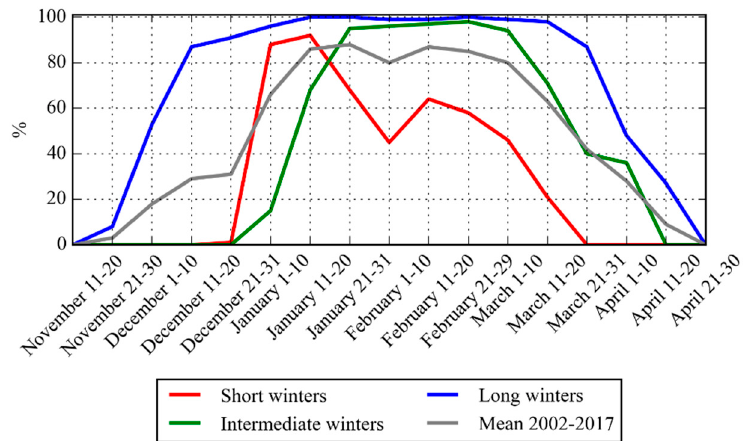
Figure 12. The 10-day averaged percentage of the ice cover extent in the Curonian Lagoon for the three winter